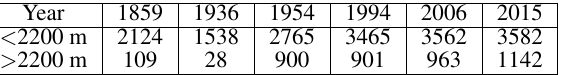
Table 8. Forest evolution in the Trentino region from 1859 to 2015 for areas below and above 2200 meters. Areas are in square kilometers.